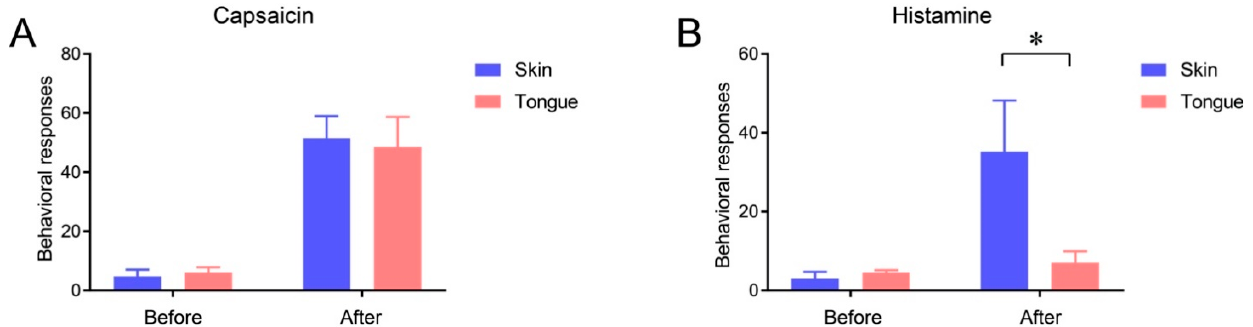
Figure 3. Lack of histamine-induced itch response from the tongue mucosa. The number of behavioral responses assessed 5 min before and after the injection of capsaicin (10 µg/10 µl ( A) ) or histamine (20 µg/10 µl ( B )) into the facial skin or tongue of C57BL/6 mice. Under isoflurane anesthesia, capsaicin or histamine was injected into the facial skin subcutaneously or into the submucosa of the dorsum of the tongue. Before and after the injection of capsaicin into the facial skin, the number of wipings of the injected skin using the ipsilateral hind paw was counted. Before and after histamine injection into the facial skin, the number of scratchings of the injected site using the ipsilateral forepaw was counted. Upon the injection of capsaicin or histamine into the tongue, the number of instances of wiping, scratching, and grooming of the face using the bilateral forepaws was counted. n = 4 in each group. * p < 0.05 in post-test following two-way repeated measures ANOVA.